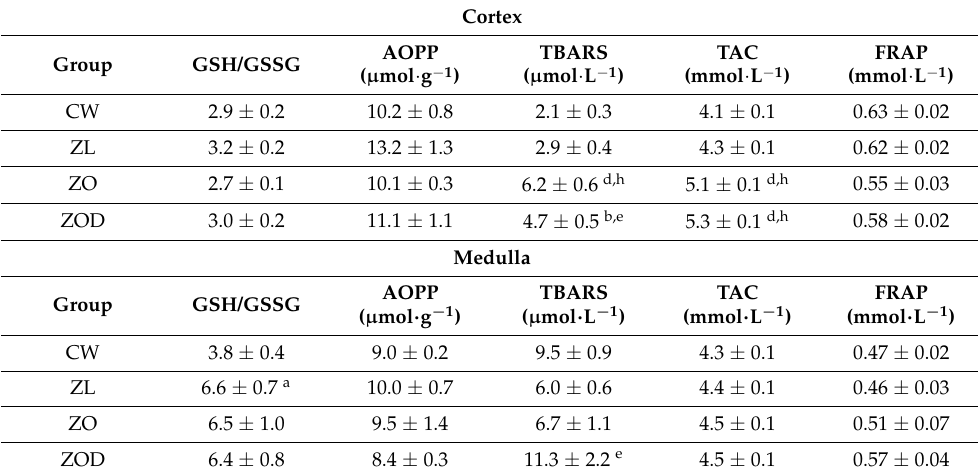
Table 2. Parameters of oxidative stress and antioxidant status in the renal tissue.